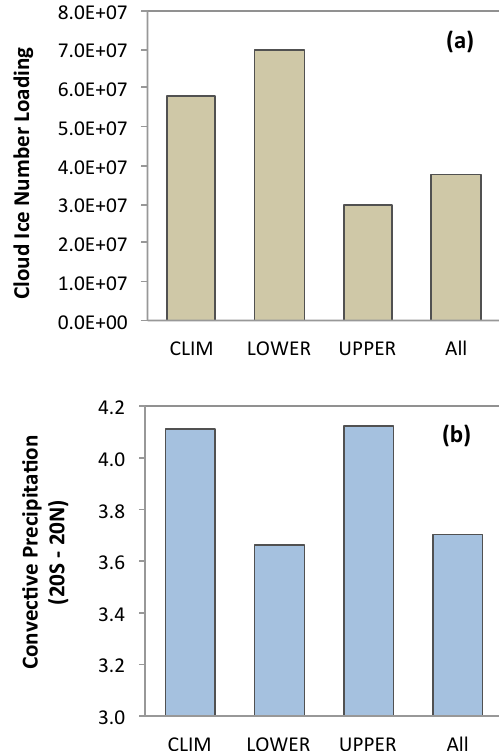
Figure 6. (a) Global mean cloud ice number loading between 100hPa and 300hPa (units: m − 2 ), and (b) tropical (20 ◦ S–20 ◦ N) mean convective precipitation rate (mm day − 1 ), in various CAM5 simulations using present-day aerosol and precursor gas emissions. CLIM: without nudging; LOWER: temperature was nudged to- wards the ERA-Interim analysis in the lower 15 levels (roughly from 300hPa to the surface, NDG_ERA_LOWER in Table 1); UPPER: temperature was nudged towards the ERA-Interim anal- ysis in the upper 15 levels (roughly from model top to 300hPa, NDG_ERA_UPPER in Table 1); All: temperature on all model levels was nudged towards ERA-Interim (NDG_ERA_UVT in Ta- ble 1). In the latter three simulations, horizontal winds were nudged towards ERA-Interim on all levels. The nudging time scale, when applicable, was 6h. Details of the experimental setup are explained in Sect. 2.3 and Table